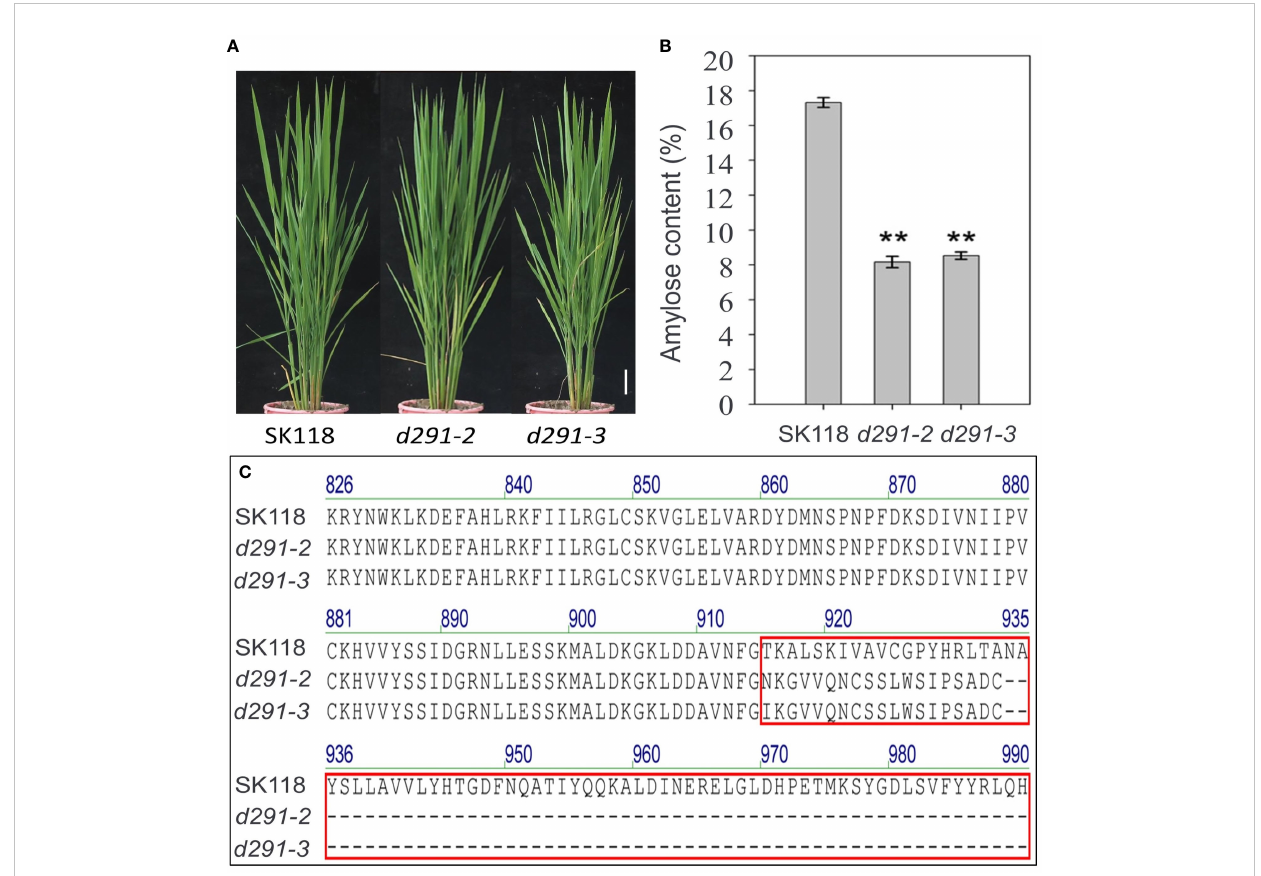
FIGURE 2 Phenotype and amino acid variations assays. (A) Phenotypes of fl o2 mutant lines ( d291-2 and d291-3 ) in SK118 background. Bar = 5 cm. (B) Amylose content (%). Data are given as the mean ± S.D. (n ≥ 3). Student ’ s t test: *P < 0.05; **P < 0.01; ns, no signi fi cance. (C) Amino acid variations of the FLO2 protein in the fl o2 mutant. Wild-type, SK118. Homozygous mutations identi fi ed at the target sites of d291-2 and d291-3 mutant lines in the T1 generation. Amino acid variations were indicated in red box, with the number representing the order in the proteins. The ellipsis dots represent premature stop